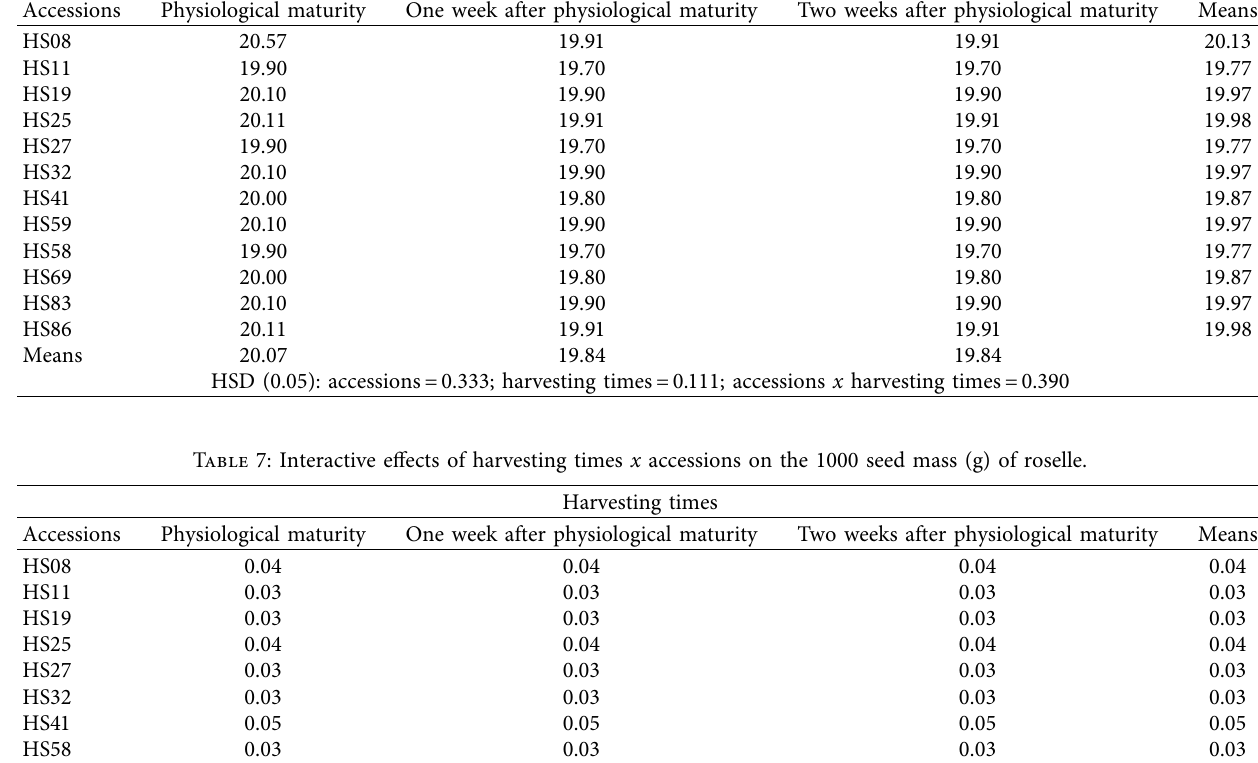
Table 6: Interactive effects of harvesting times x accessions on the angle of repose (0) of roselle. Harvesting times